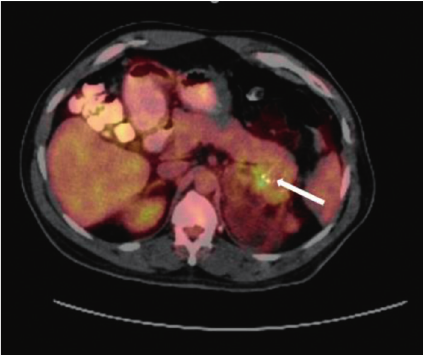
Figure 3: A positron emission tomography (PET) scan demon- strating metabolic uptake with focality localizing to the enhancing solid component of the left adrenal mass seen on the multiphase CT study.